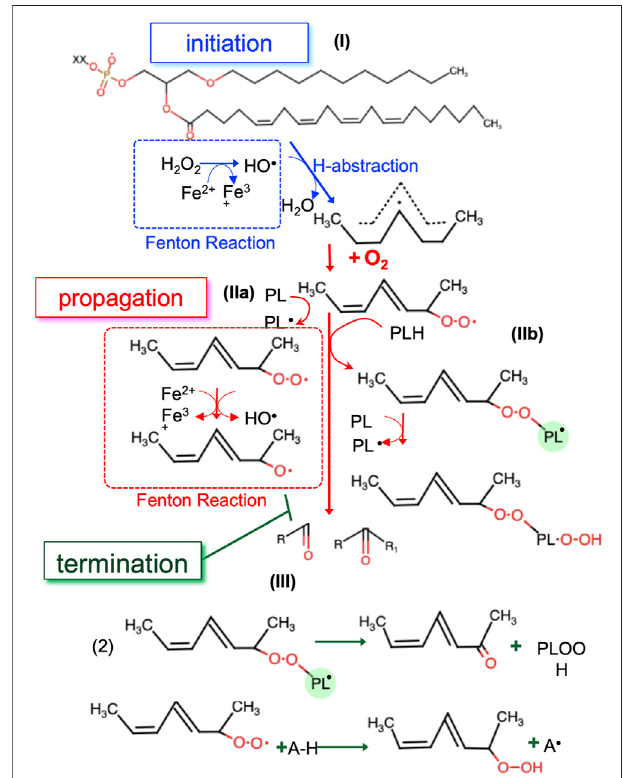
FIGURE 4 | The three steps of non-enzymatic LPO. In the initiation step the fi rstradicalsaregeneratedbyredoxactivelabileiron (I) .Inthepropagation step radicals are able to react with new substrates, creating new radicals (II) . The propagation step repeats until the termination step, where radicals are ‘ quenched ’ by antioxidants or reacting with another radical (III) . hydroxyl radical; PL, phospholipid; PL-OO phospholipid radical, Fe 2+ , ferrous ion, Fe 3+ , ferric ion, PL-O radicals; A-H,